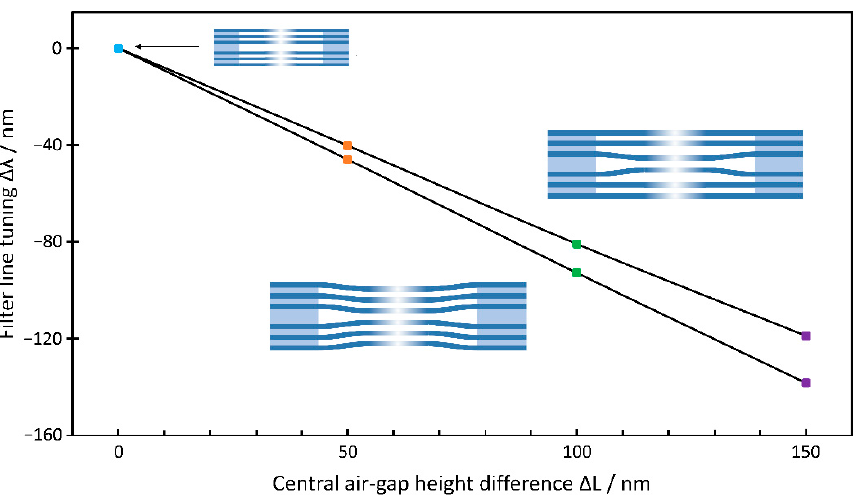
Figure 19. Electrostatic MEMS tuning of InP multiple air-gap filters with two different cases: Actuating all membranes of the DBRs (lower curve) and actuating only the two central membranes (upper curve). The colors of the symbols correspond to those used in Figure 18.